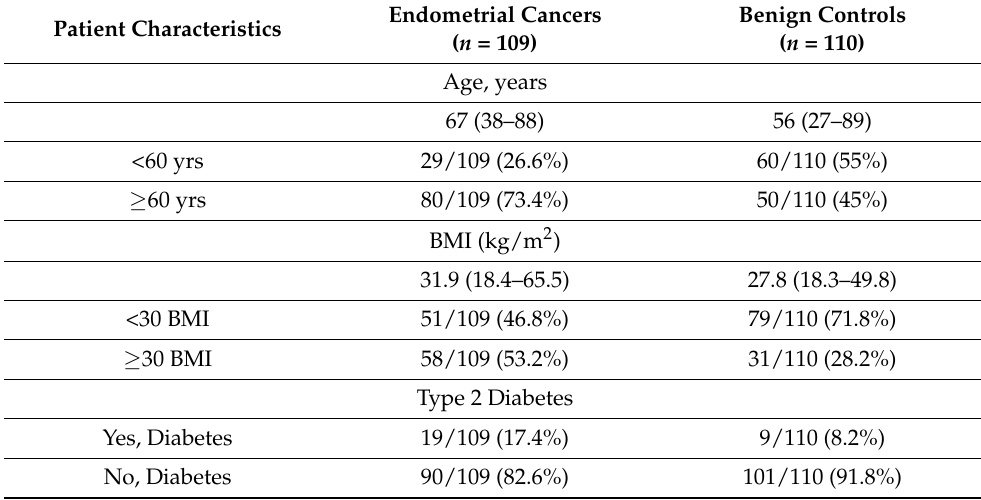
Table 1. Patient demographics and clinical